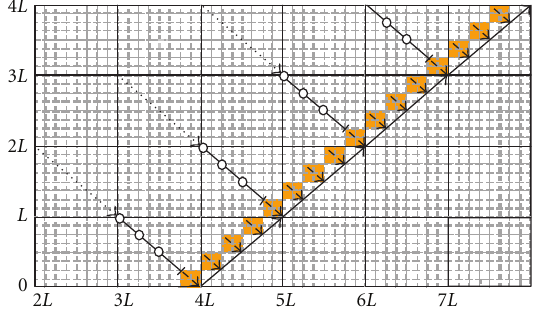
Figure 11: DFG for pointer technique based single-flow structure (SFS, Π = L , π = 1, 3